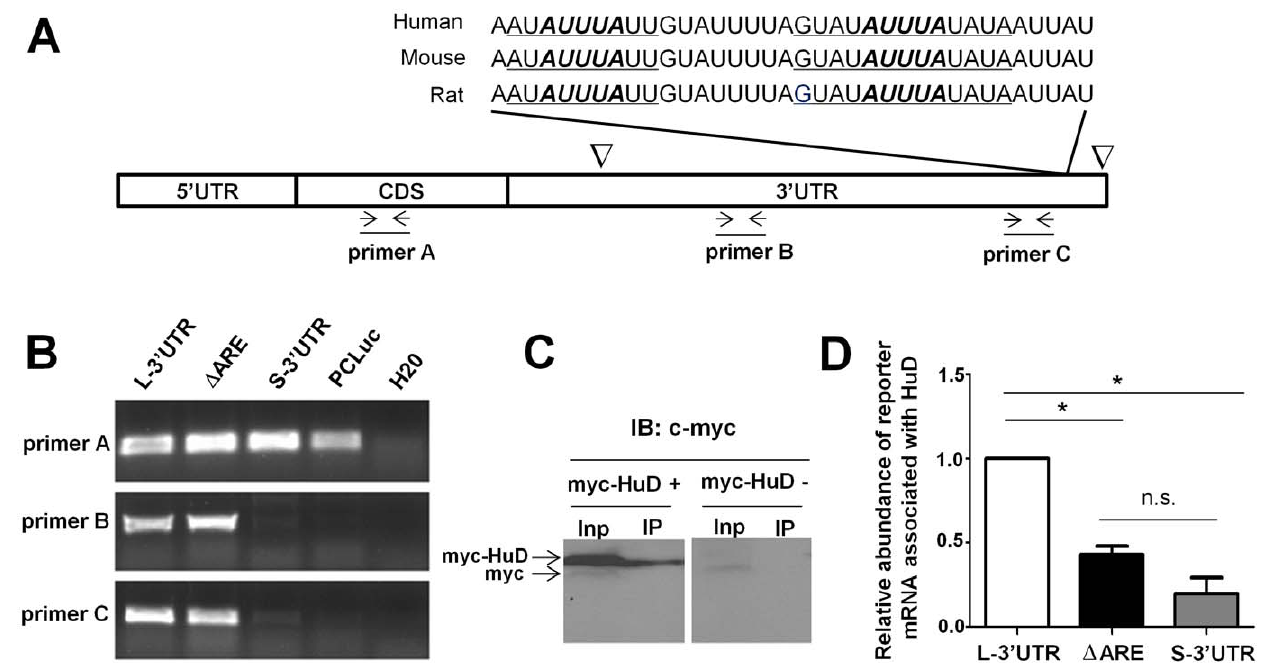
Figure 1. HuD enhances luciferase reporter expression through an ARE in the BDNF long 3 9 UTR. (A) A highly conserved cluster of Class I ARE in the BDNF long 3 9 UTR, with a consensus core sequence of AUUUA flanked by symmetric A or U (underlined). Triangles indicate alternative polyadenylation sites in the BDNF primary transcript. Primers used for RT-PCR to detect reporter mRNAs are illustrated underneath. (B) RT-PCR using multiple primers illustrated in (A) confirms expression of the expected RNA sequence from each transfected reporter construct. (C) Immunoblot (IB) showing expression of myc-HuD in the input (Inp) of transfected CAD cells and successful immunoprecipitation (IP) of myc-HuD. Two different anti- myc antibodies were used for IP and IB. (D) CLIP-qRT-PCR quantification of reporter mRNAs co-immunoprecipitated with HuD relative to the corresponding mRNA levels in the input. * indicates P , 0.05 by Student’s t-test (n=3). Due to the presence of endogenous BDNF mRNA, primers specific for the luciferase coding region were used to detect reporter mRNAs. BDNF long 3 9 UTR reporter mRNA is preferentially enriched over